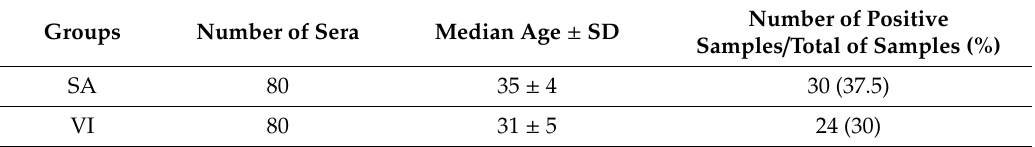
Table 2. Prevalence of IgG antibodies reacting to HPV-16 L1 capsid protein detected in sera from SA and VI groups.